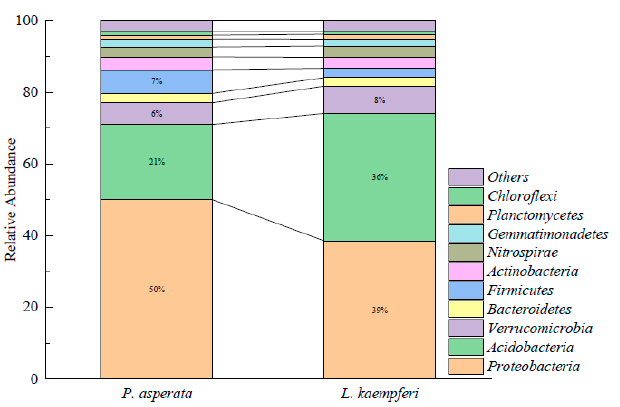
Figure 6. Top ten bacterial phylum of the two soil groups from P. asperata and L. kaempferi forest. Alpha diversity measured by the Shannon ( H’ ) index, chao1 and observed species, showed significant differences between two different forest types. Lower values were observed in the P. asperata forest, with values of 8.80, 2799.40, and 2706, respectively, while those in the L. kaempferi forest were 8.86, 3565.47, and 3040, respectively (Figure 7). This pattern was similarly to the plant alpha diversity.